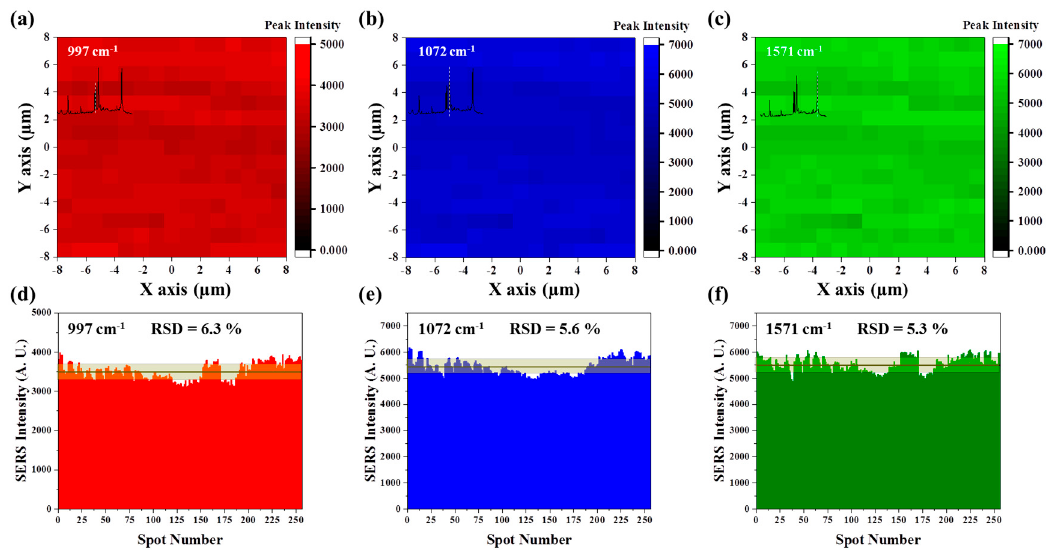
Figure 3. High uniformity of Raman intensity. ( a – c ) Spatial distribution of Raman intensities of benzene thiol (BT) at characteristic peak positions of ( a ) 997 cm − 1 , ( b ) 1072 cm − 1 , and ( c ) 1571 cm − 1 acquired by micromapping. ( d – f ) Variation of Raman intensities on 256 spots. The relative standard deviation (RSD) of the intensity is denoted in each panel.